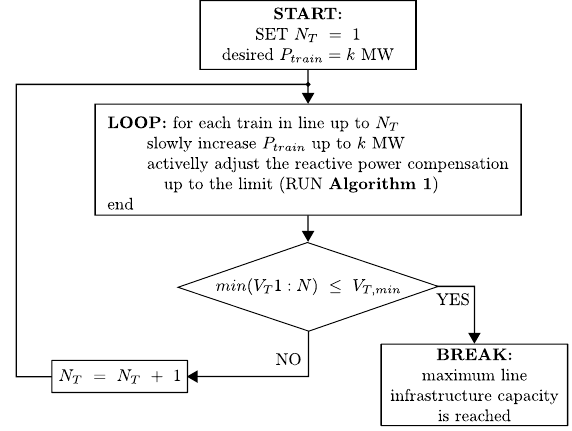
Figure 12. Flowchart to test the increasing of capacity